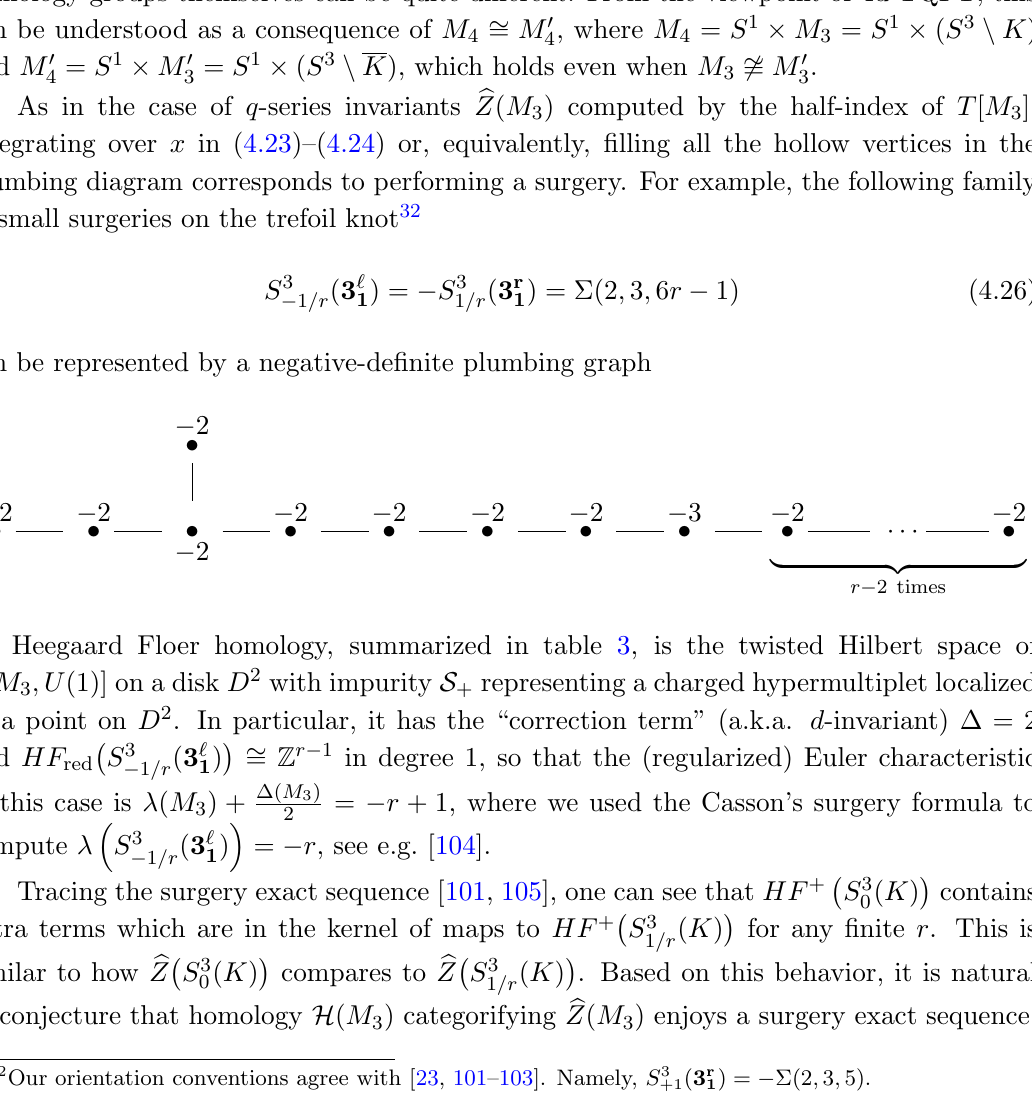
(cid:0) (cid:1) S 3 ( K ) can not be viewed as a limit of HF + 0